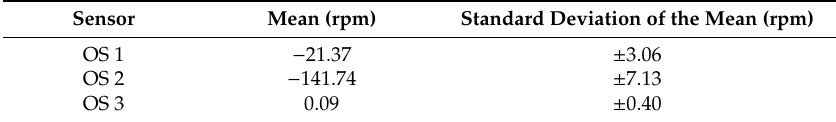
Table 1. Statistical analysis of OS 1, OS 2, and OS 3 working at 4945 rpm using the trailing edge of the datum feature.